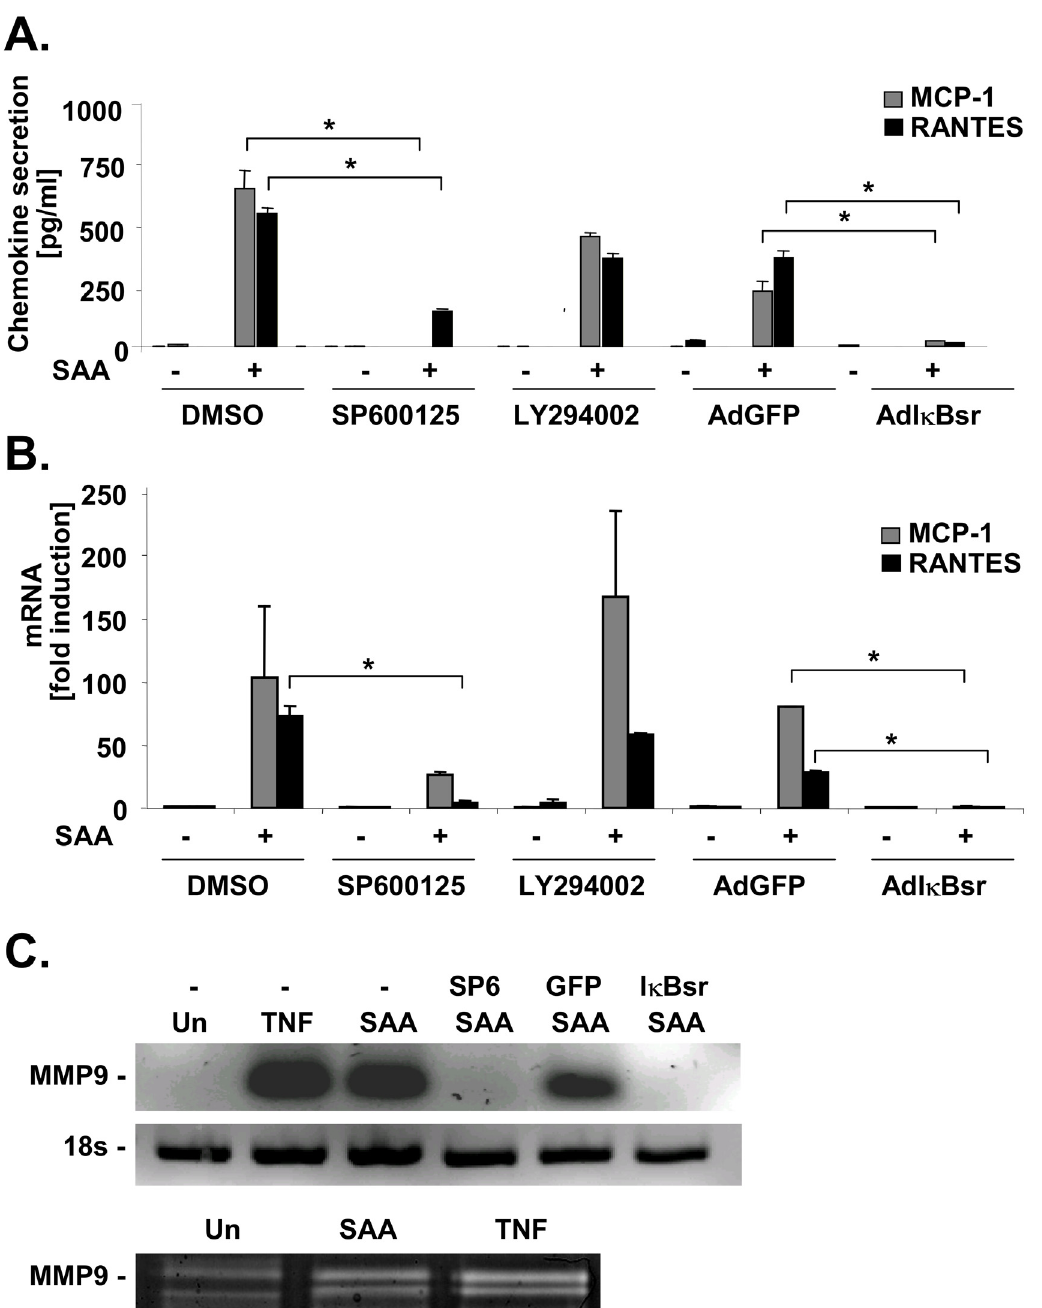
Fig 2. SAA induces chemokine and MMP 9 expression in HSCs in an NF- κ B- and JNK-dependent manner in HSCs. Activated human HSCs were treated with rhSAA in the prescence or absence of JNK inhibitor SP600125 (20 μ M), or after infection with adenoviruses expressing either I κ Bsr or GFP. A. 24 hours after rhSAA treatment, supernatants were analyzed for MCP-1, IL-8 and RANTES secretion by ELISA. B-C. 6 hours after rhSAA treatment, RNA was extracted and analyzed for mRNA levels of MCP-1, IL-8 and RANTES ( B ) or MMP9 ( C ) by quantitiative real time PCR ( * p < 0.05 vs. SP600125 treatment or I κ Bsr infection, resp.). D. 24 hours after SAA treatment, proteins were extracted and MMP9 activity was analyzed by